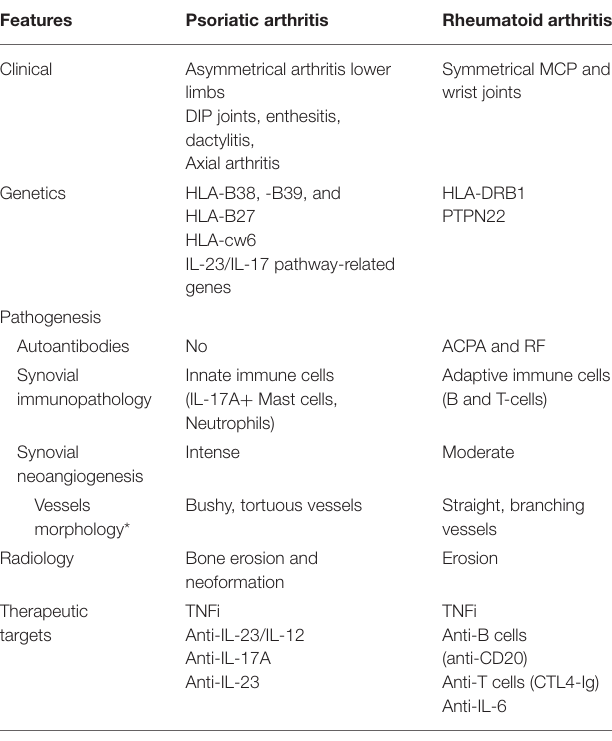
TABLE 1 | Differences between PsA and